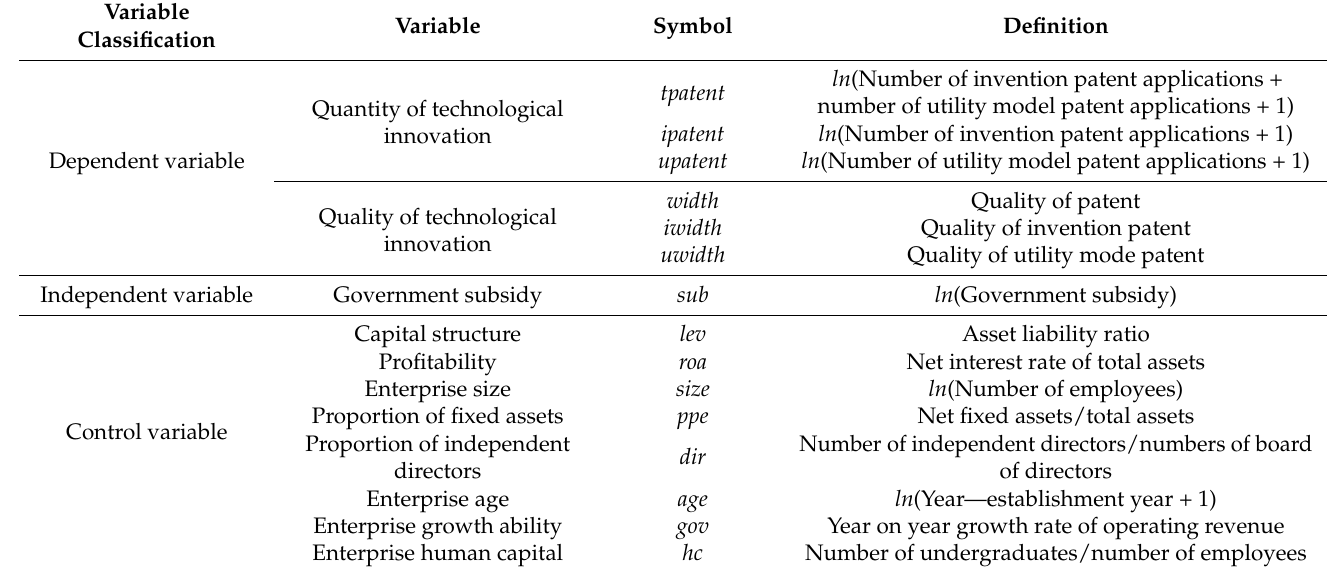
Table 1. Definition of the